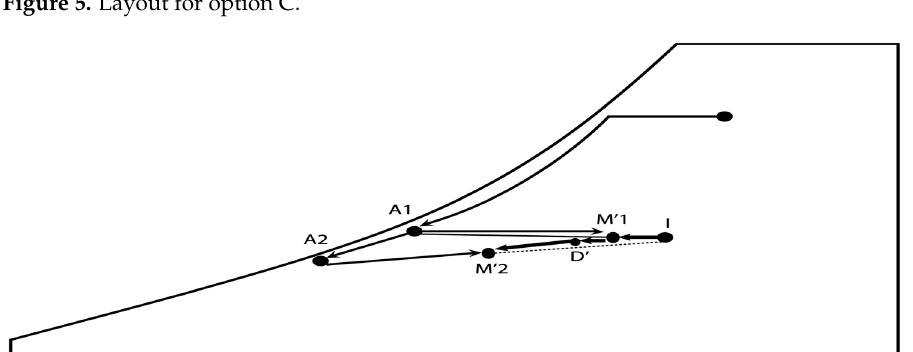
Figure 5. Layout for option C.